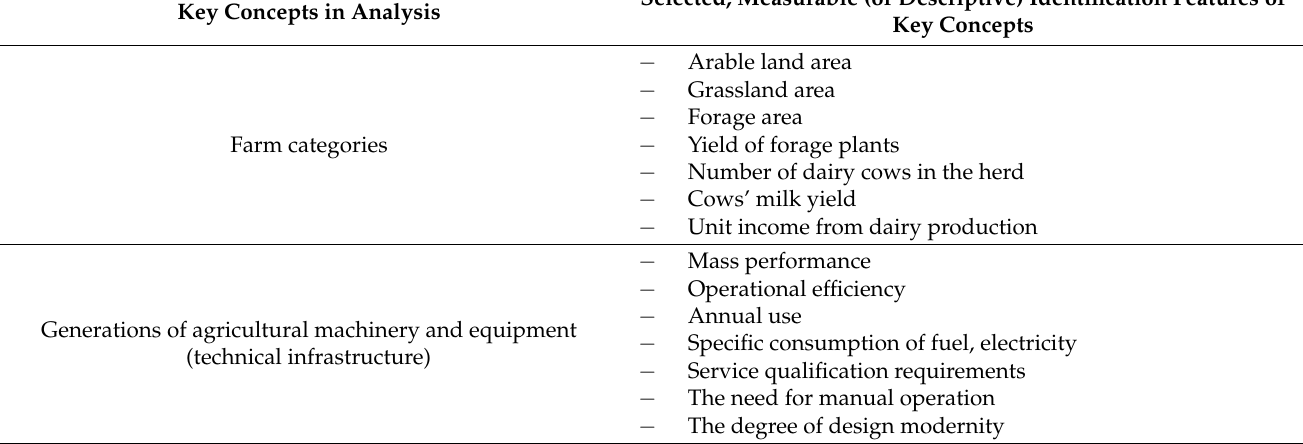
Table 2. Selected, measurable, and descriptive features of key concepts in the analysis of milk production on a farm, including elements of fodder and livestock production. Key Concepts in Analysis